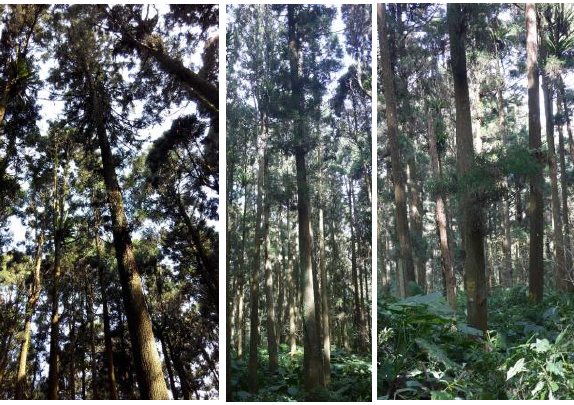
Figure 2 Sprout of forest